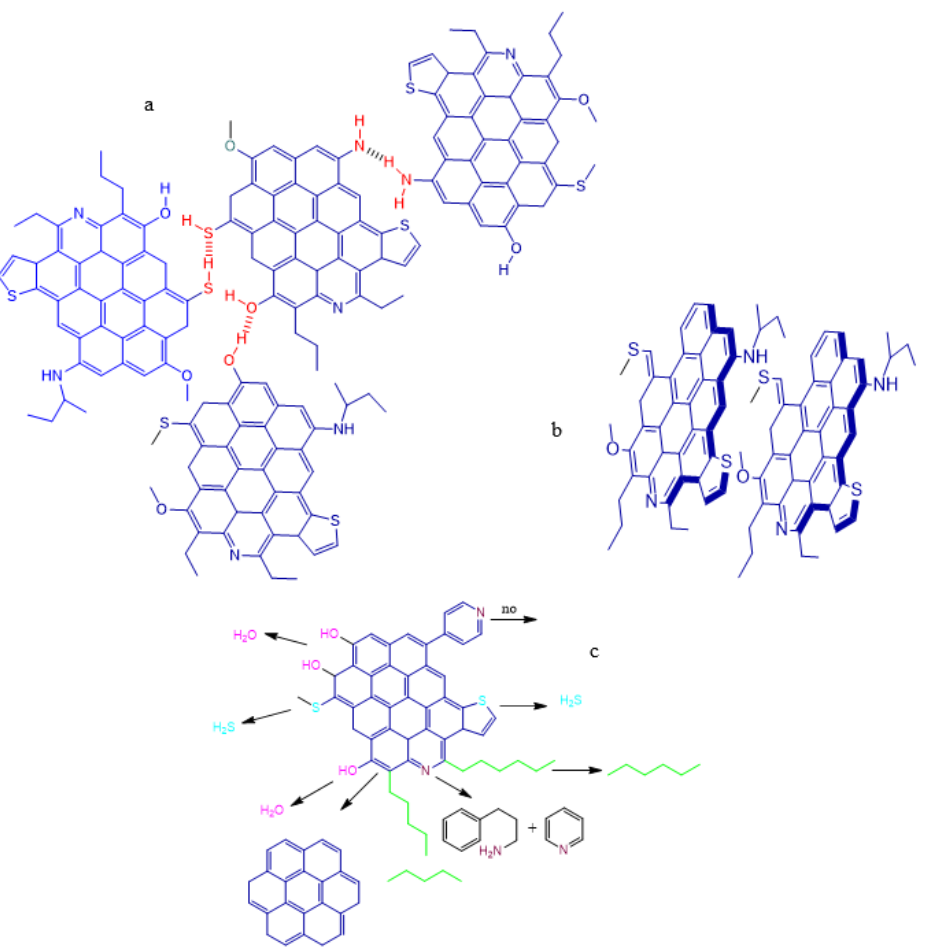
Figure 14. Schematic diagram of catalytic aquathermolysis in heavy oil ( a ) heteroatoms of S, N, and O; ( b ) 3-D network and ( c ) monocyclic compounds.